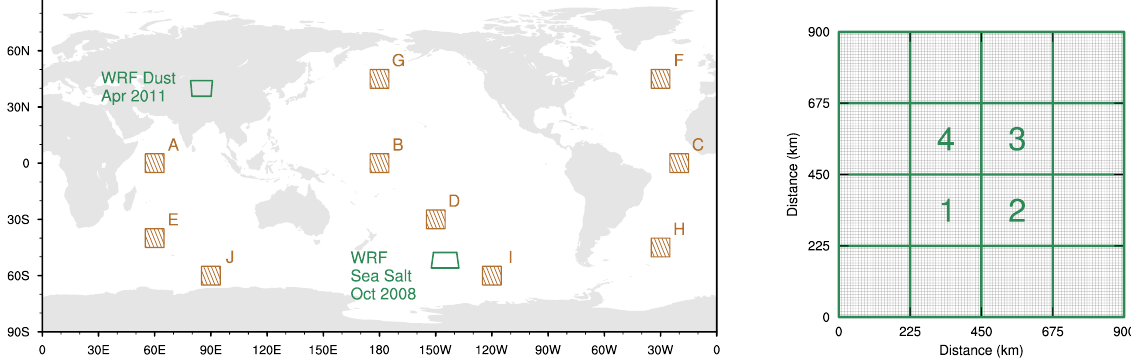
Figure 1. Left panel indicates the two 900km × 900km WRF domains (green), and the ten 10 ◦ lat × 10 ◦ long regions (brown) in which the estimated sub-grid wind variabilities are evaluated in Fig. 8. Right panel shows the four imagined 225km grid boxes (label as 1–4) in each of the WRF domains shown in the left panel. The 225km grid boxes are used for the offline estimates in Figs. 4 and 6, as well as the evaluations in Figs. 9 and 11.